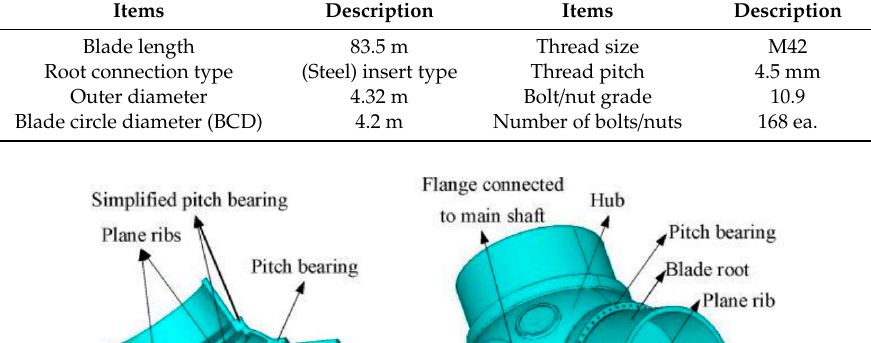
Table 1. Root joint model description of a large wind turbine rotor blade.